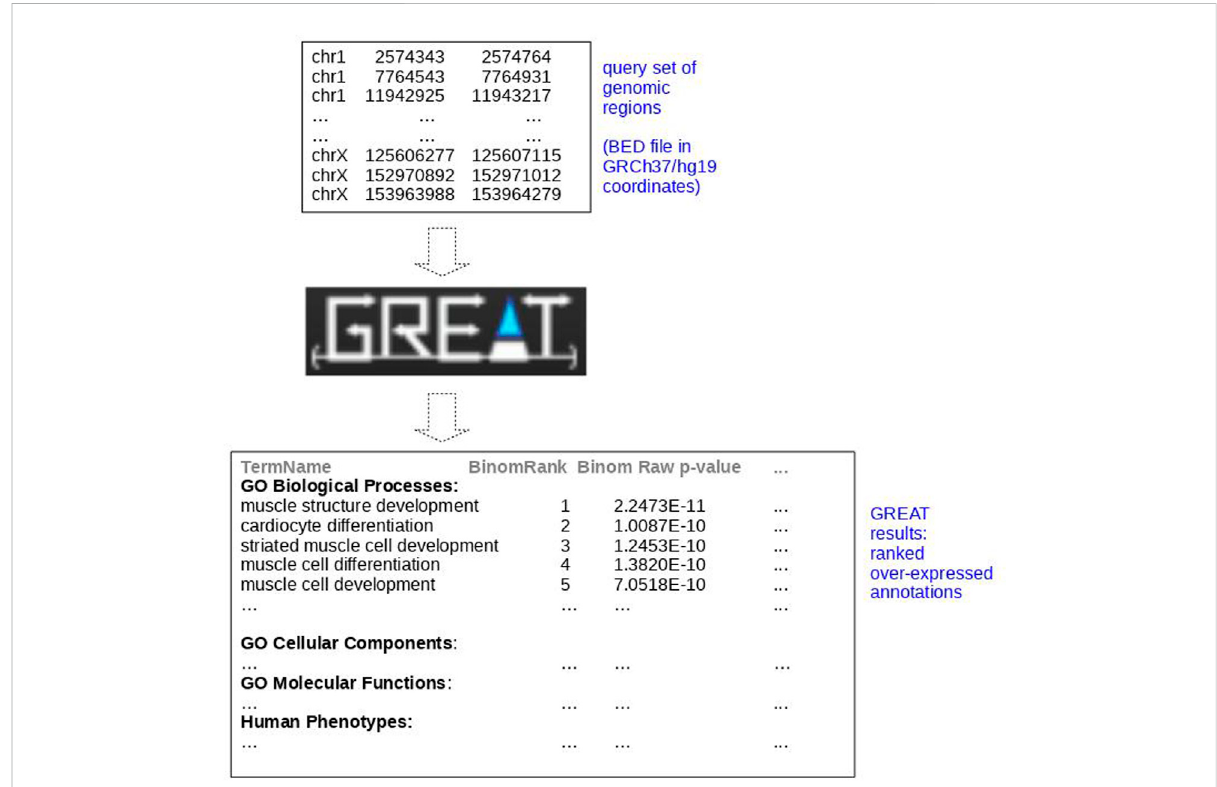
FIGURE 2 Schematic example of application of GREAT to SlideBase enhancer genomic regions of the heart. Representation of the application of GREAT (McLean et al., 2010) to query genomic regions of the heart downloaded from SlideBase (SlideBase, 2014; Ienasescu et al., 2016) in GRCh37/ hg19 coordinates. We obtained these results with GREAT default parameters (basal plus extension, proximal: 5 kilo base pairs upstream, 1 kilo base pairs downstream, plus distal: up to 1000 kilo base pairs). PEA: pathway enrichment analysis, functional enrichment